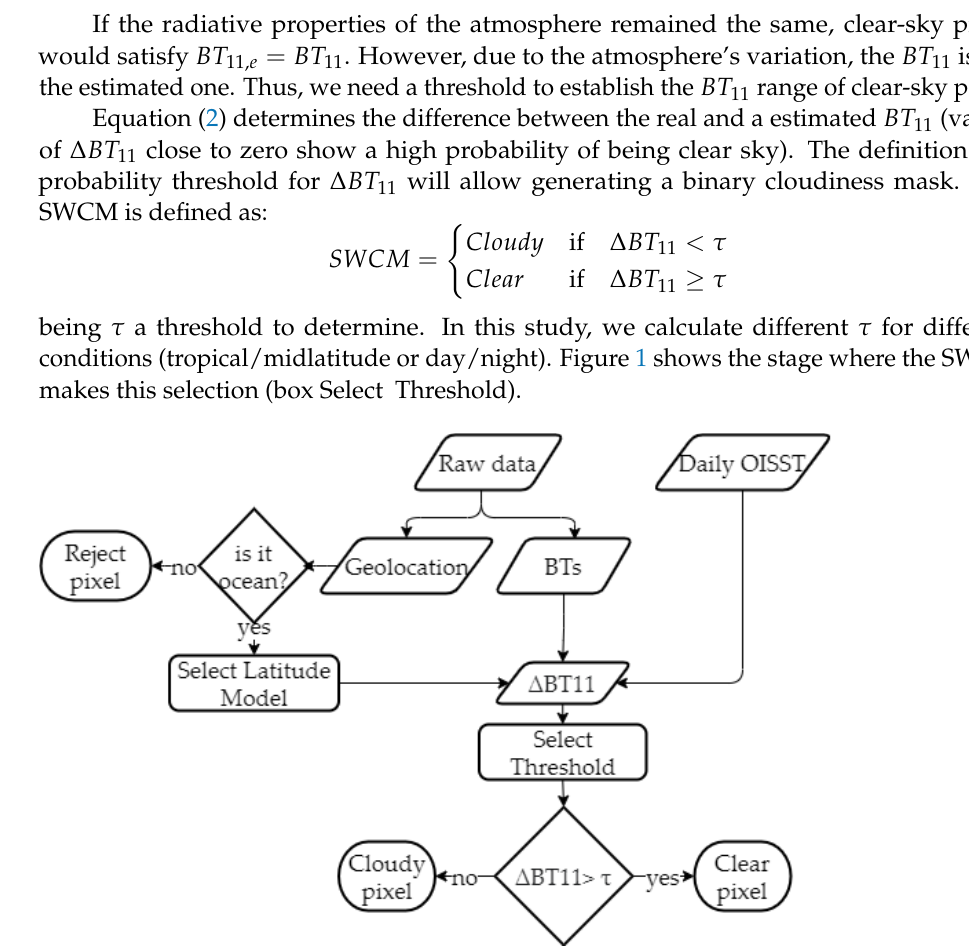
Figure 1. This flowchart shows the process that the SWCM follows when determining whether a pixel is clear or